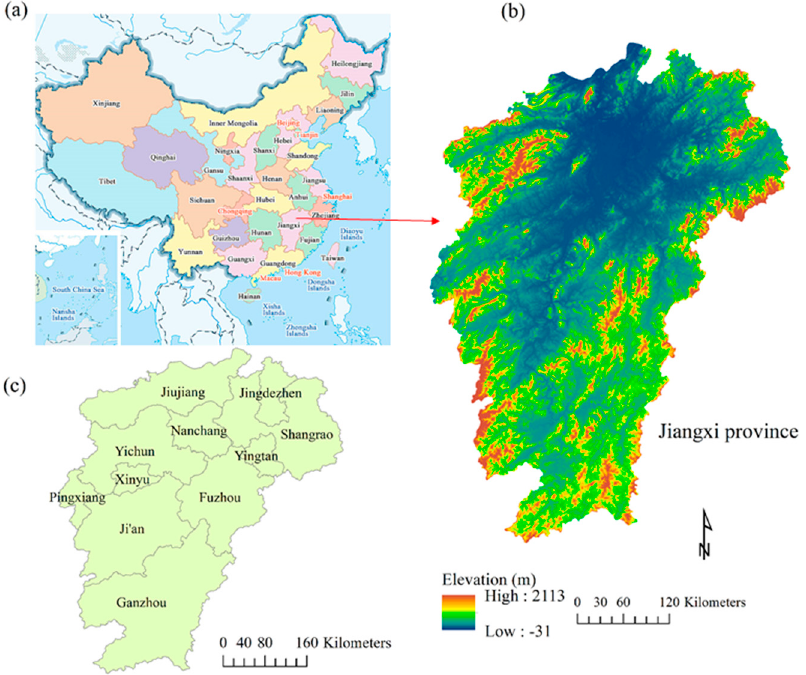
Figure 1. Location of Jiangxi province, China. ( a ) Map of China (source: www.travelchinaguide.com); ( b ) elevation of Jiangxi province (sourced from SRTM images); and ( c ) eleven prefecture-level cities of Jiangxi province.